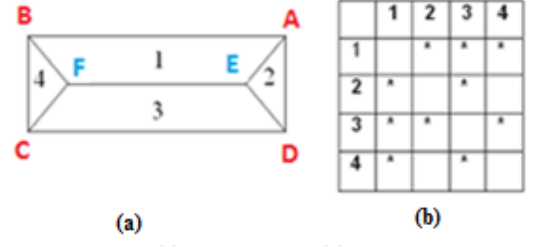
Figure 7. (a) Building roof, (b) Adjacency matrix